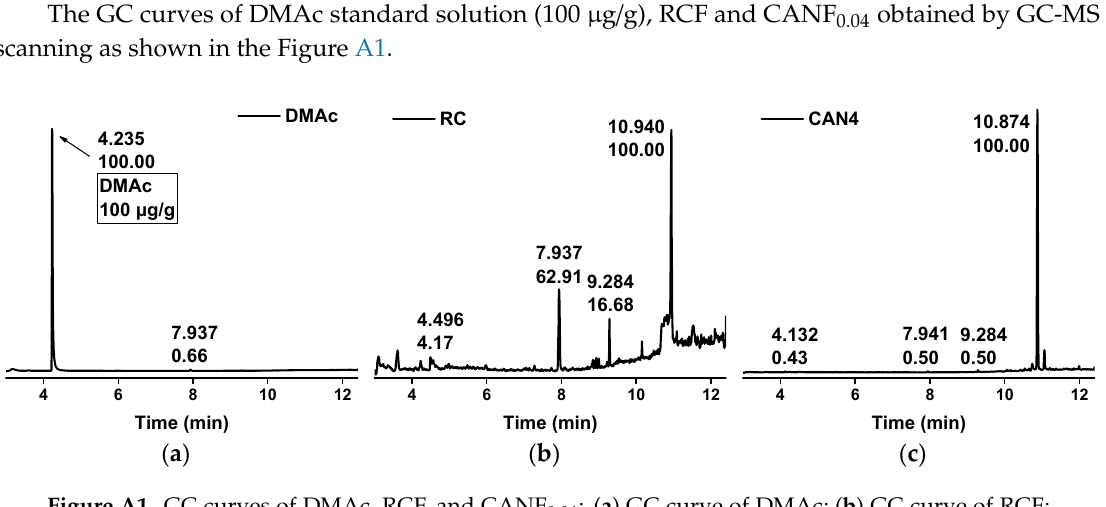
Figure A1. GC curves of DMAc, RCF, and CANF 0.04 : ( a ) GC curve of DMAc; ( b ) GC curve of RCF; ( c ) GC curve of CANF 0.04 .